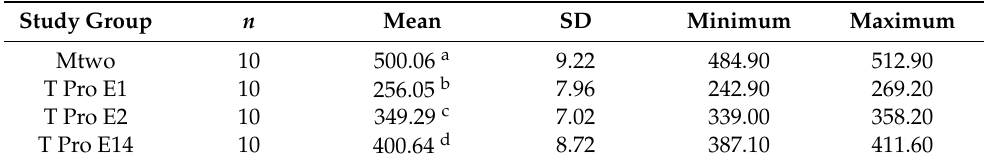
Table 2. Descriptive statistics of the time to failure of Mtwo NiTi alloy endodontic rotary files, T Pro E1 austenite phase NiTi alloy endodontic rotary files, T Pro E2 austenite phase NiTi alloy endodontic rotary files, and T Pro E4 austenite phase NiTi alloy endodontic rotary files.